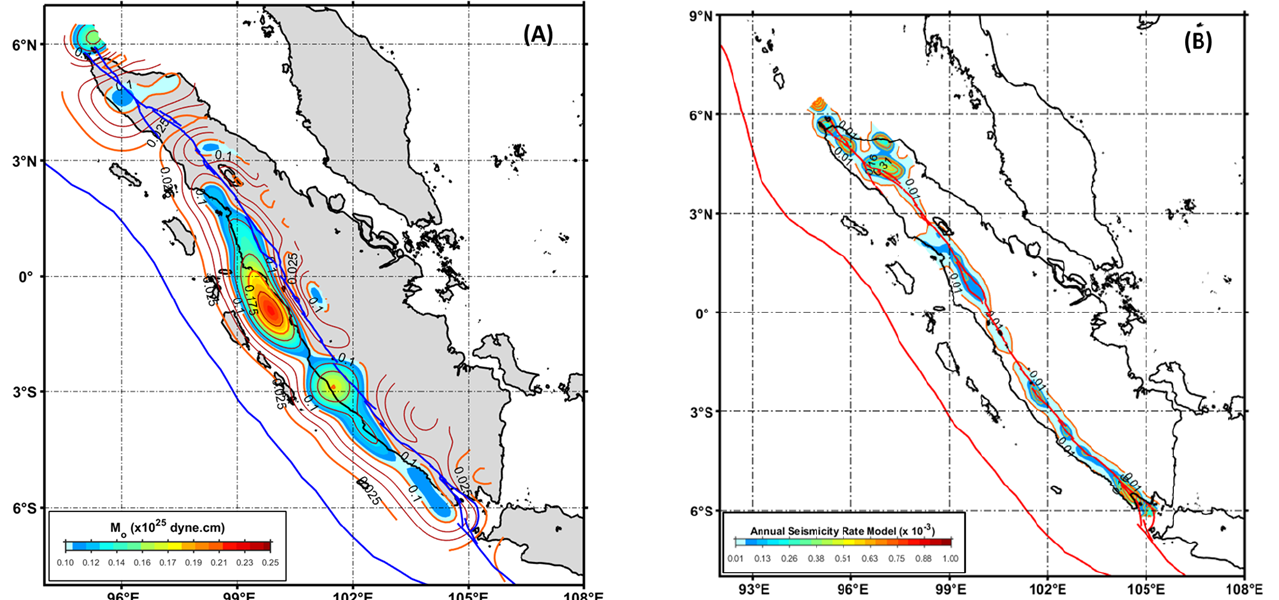
Figure 5. The estimated seismic moment rate is based on the horizontal crustal strain model around Sumatra Island ( A ). The annual seismic rate model for the SHF calculation was constructed based on the seismic smoothing of the earthquake catalog weighted by the normalized fault seismic model and the normalized seismic moment rate model based on the GPS data ( B ).